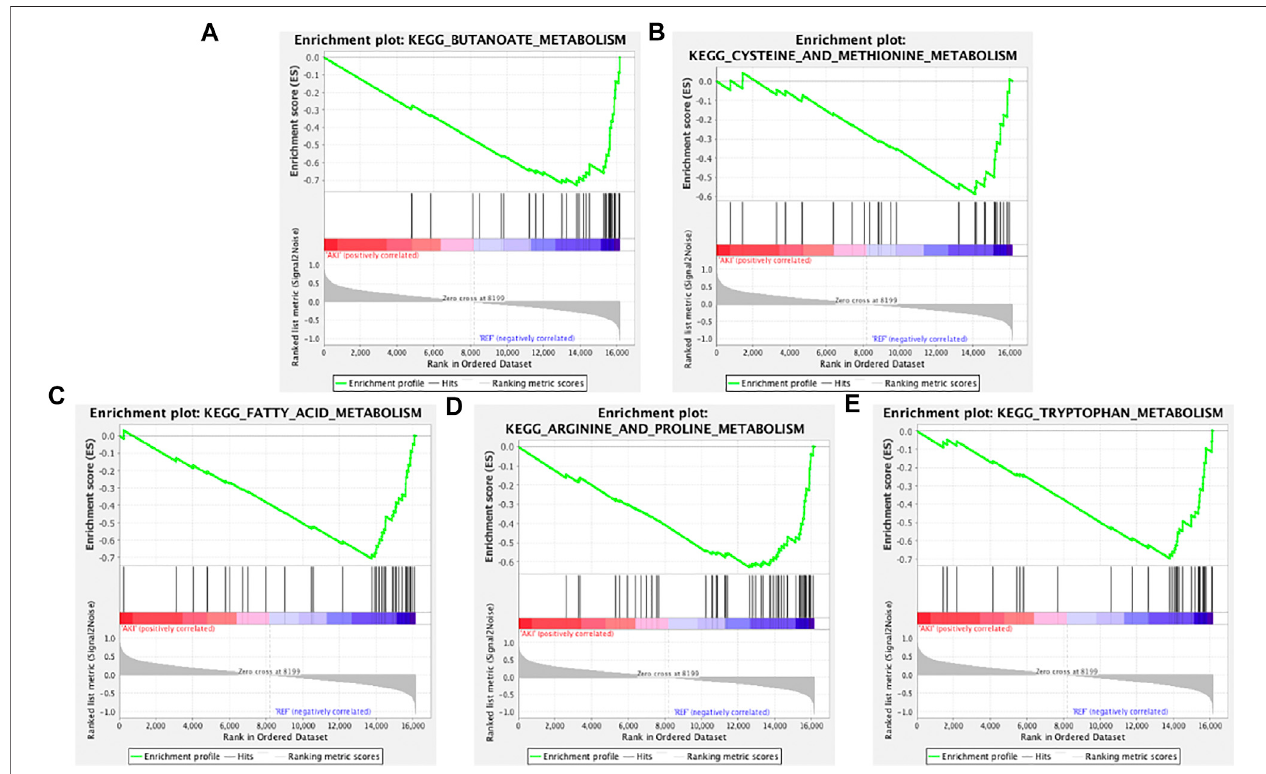
FIGURE 3 | Enrichment plots from GSEA of downregulated pathways in AKI. GSEA results showing the downregulated pathways of (A) “ butanoate metabolism, ” (B) “ cysteine and methionine metabolism, ” (C) “ fatty acid metabolism, ” (D) “ arginine and proline metabolism, ” and (E) “ tryptophan metabolism. ”